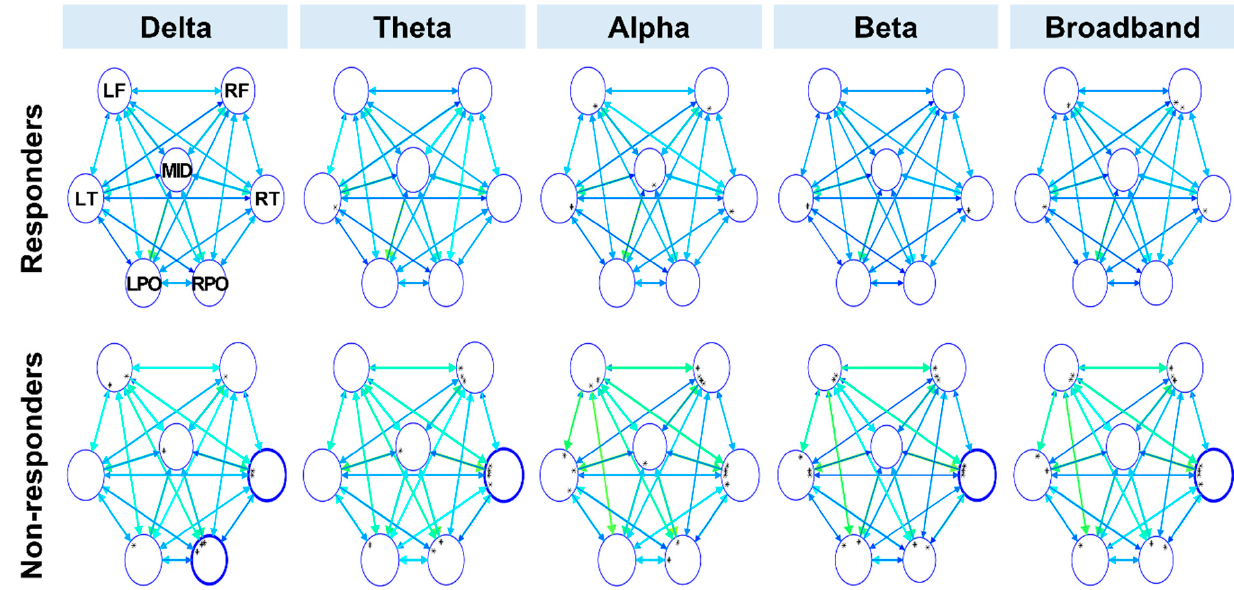
Figure 1. Presurgical inflow connectivity analysis of the responder and nonresponder groups compared with the control. Note that each circle denotes a node and that the diameter of the circle represents nodal strength, which is the sum of all connections toward the node. The strength of the information flow is indicated by the color of the edges. Thickened circles represent nodes with significantly greater inflow connectivity compared with those of the control. LF—left frontal; RF—right frontal; LT—left temporal; RT—right temporal; LPO—left parieto-occipital; RPO—right parieto-occipital.